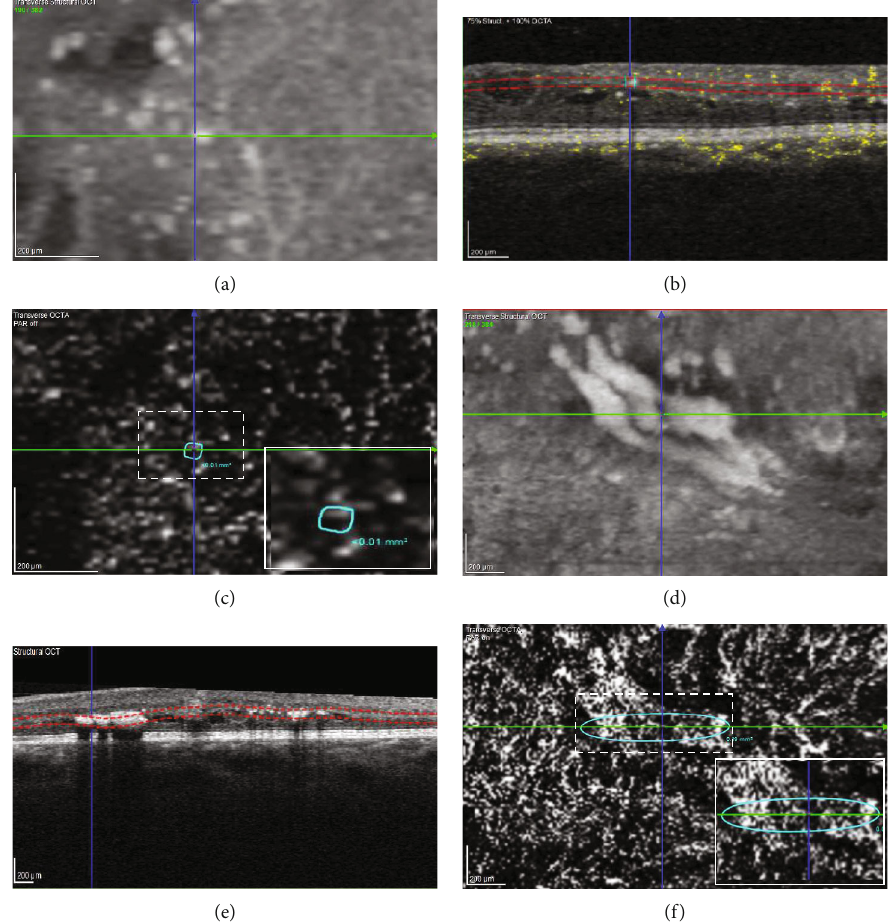
Figure 2: Multimodal imaging of vascularized inner retinal layer (IRL) (IRL) hyperre fl ective foci (HF) and hard exudates (HE). (a, d) The structural optical coherence tomography (OCT) delineates dot-like HF (a – c) and spot-like HE (d – f) in a 39-year-old patient with mild nonproliferative diabetic retinopathy (NPDR) at baseline. (b, e) B-scan with manual segmentation of the vascular slabs of the region visualized as dashed red line, depicting HF in the inner nuclear layer (INL) and HE in the outer plexiform layer (OPL). (c, f) Corresponding en- face OCT-angiography (OCTA) images of the manually outlined vascular slabs demonstrate HF and HE deposited adjacent to blood vessels. Higher magni fi cation images of the HF and HE are marked by a dash square. Both HF and HE borders are outlined in turquoise, and area in mm 2 is calculated by the device